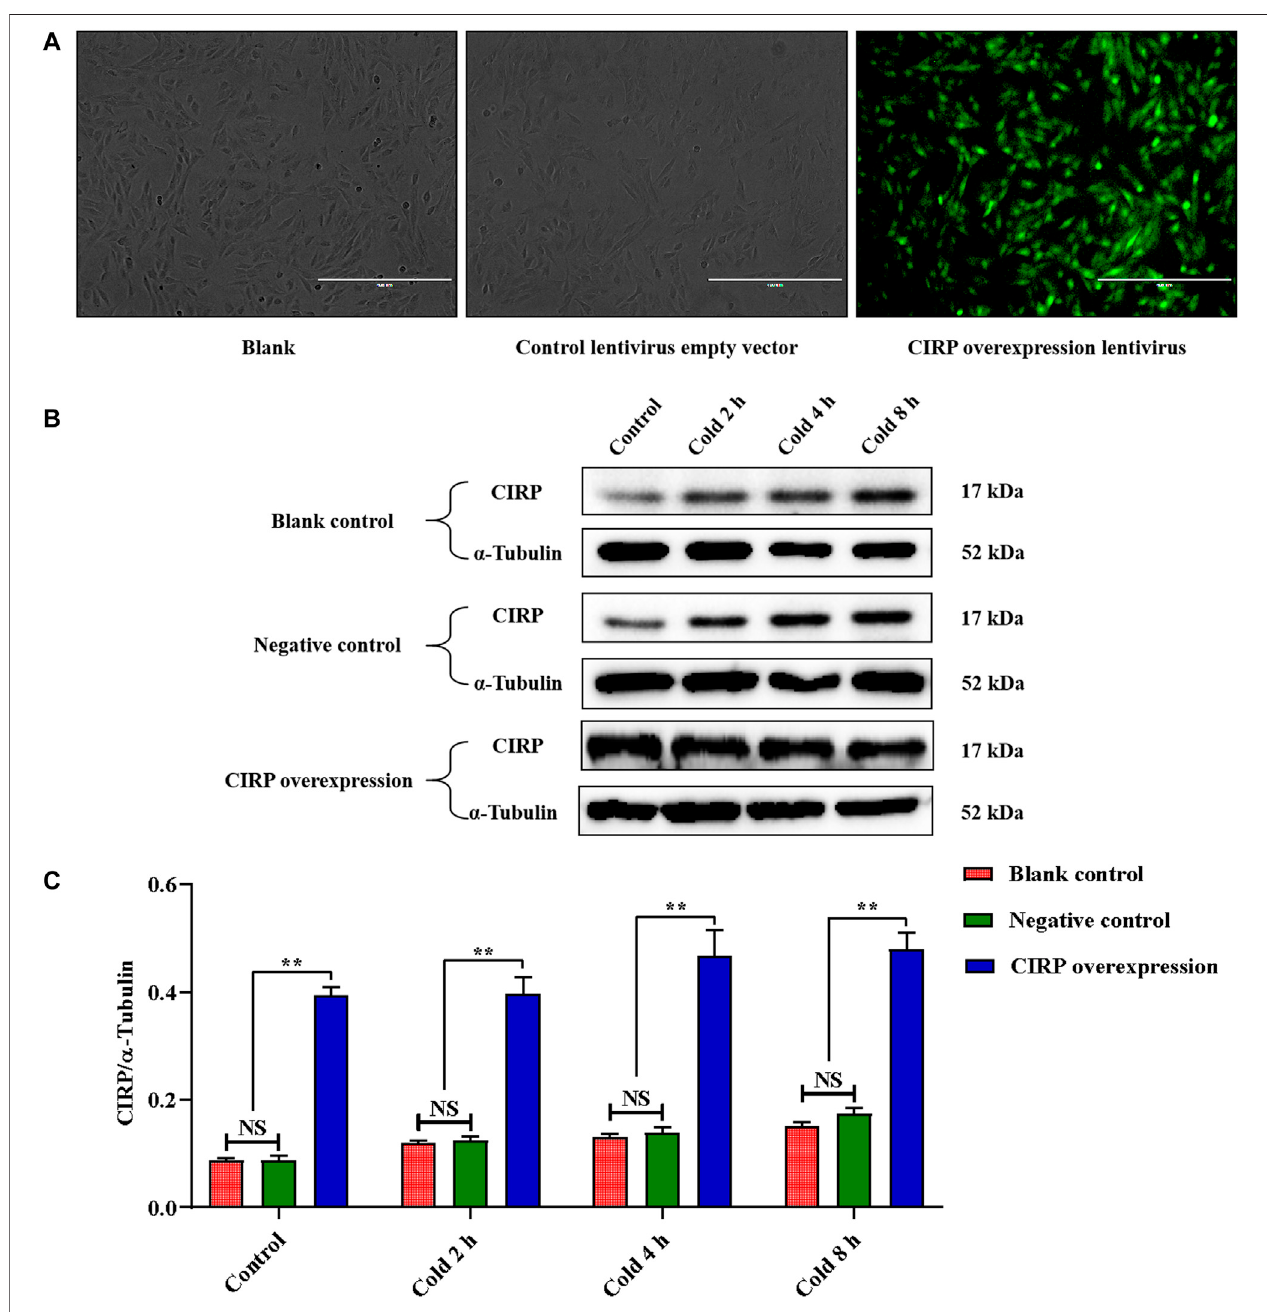
FIGURE4| EstablishmentofCIRPoverexpressionanditsexpressionchangesundermildhypothermiainC2C12cells. (A) ObservationofC2C12cellsinfectedwith CIRP lentivirus for 72 hours by fl uorescence microscope. (B, C) Effects of mild hypothermia and lentivirus infection on CIRP protein expression in C2C12 cells. The data are presented as the mean ± SEM (n (cid:1) 8). Statistically signi fi cant differences are indicated; * p < 0.05, ** p < 0.01. CIRP, cold inducible RNA-binding protein.